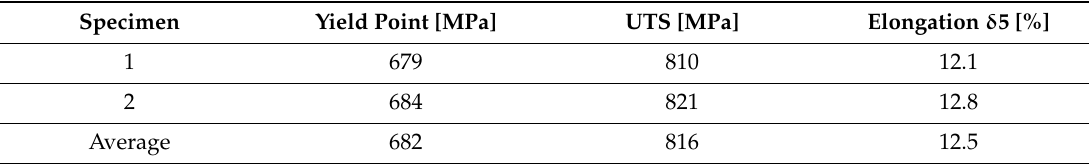
Table 4. Results of tensile test, Strenx 700 MC welded